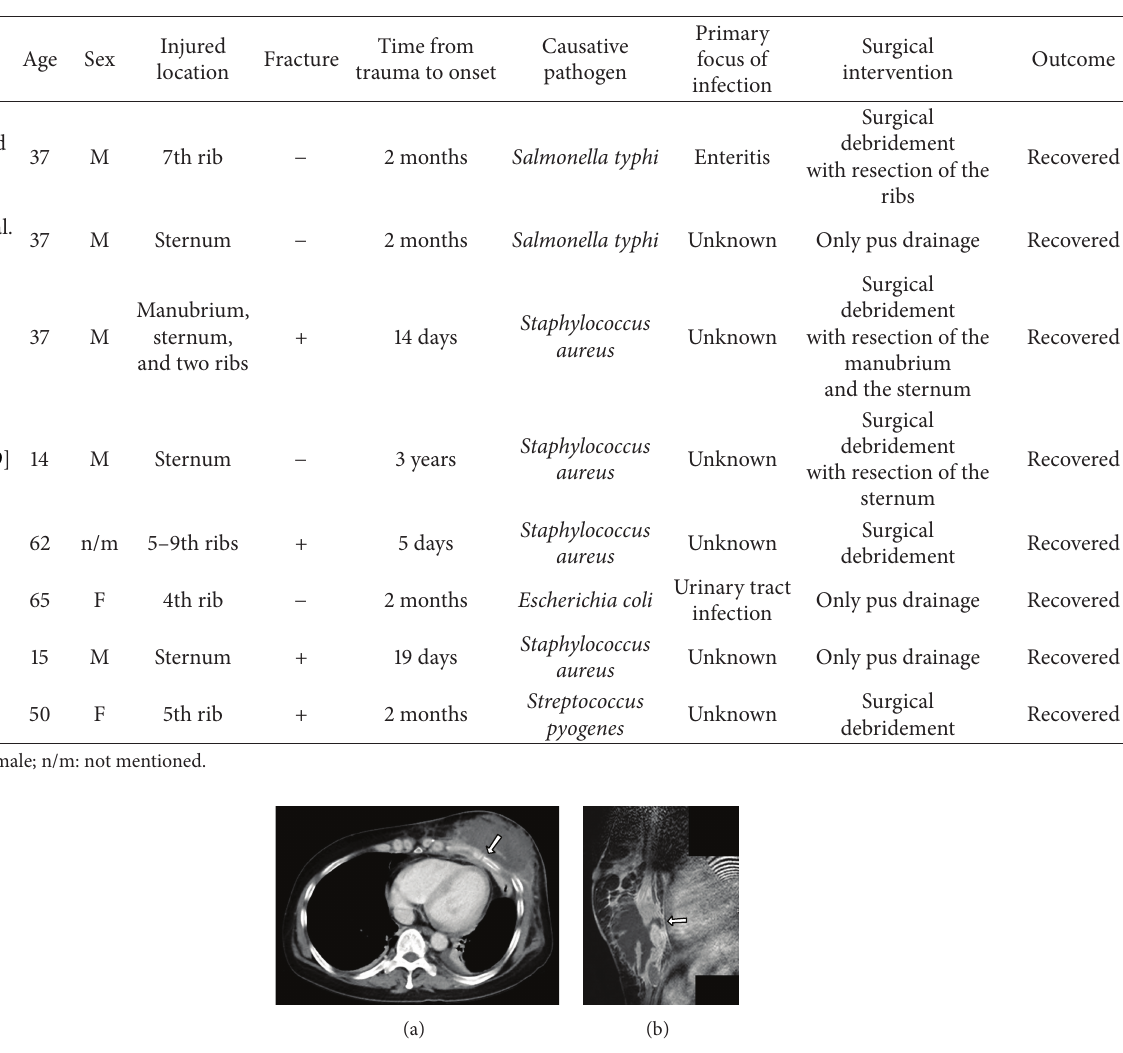
Figure 3: (a) Computed tomography (CT) showing a large mass in the lower region of the left breast. The fifth rib under the mass is fractured (arrow). (b) T1-weighted magnetic resonance imaging reveals contrast enhancement from the border of the mass to the pleura (arrow).